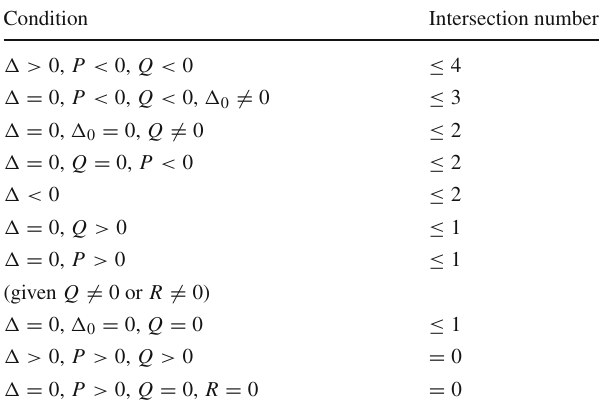
Table 5 Constraints on the intersection number for the critical point φ PT symmetric 0 when the action is